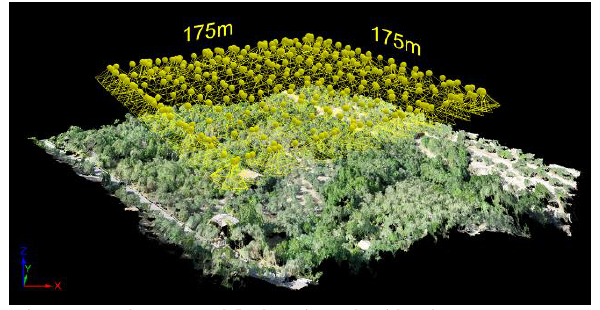
Figure 4 – The Image block oriented with Pix4D The DTM was extracted from the dense point cloud using the